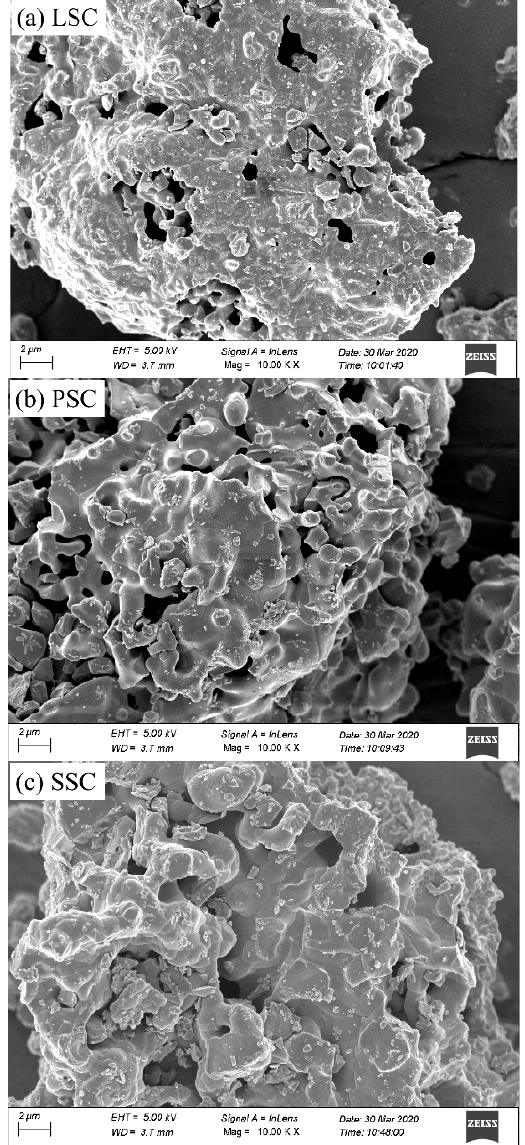
Figure 2. SEM patterns of ( a ) LSC, ( b ) PSC and ( c ) SSC powders. The cation oxidation state and the surface chemical composition of LSC, PSC and SSC were analyzed by XPS [35]. The carbon peak located at 284.71 eV could be the residual carbon after calcination of as-prepared samples [15]. The survey spectrum of LSC displayed peaks of La 3d, Sr 3d, Co 2p, O 1s and C 1s peaks according to XPS results in Figure S3a. Similarly, the survey spectrum of PSC and SSC displayed peaks of Pr 3d and Sm 3d, respectively. The corresponding binding energies of various peaks were consistent with previously reported values [36,37].